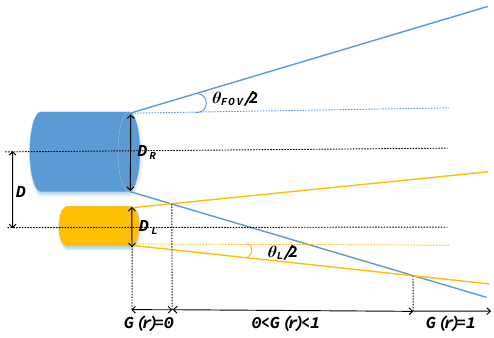
Figure 3. The geometric overlap factor changing with range.